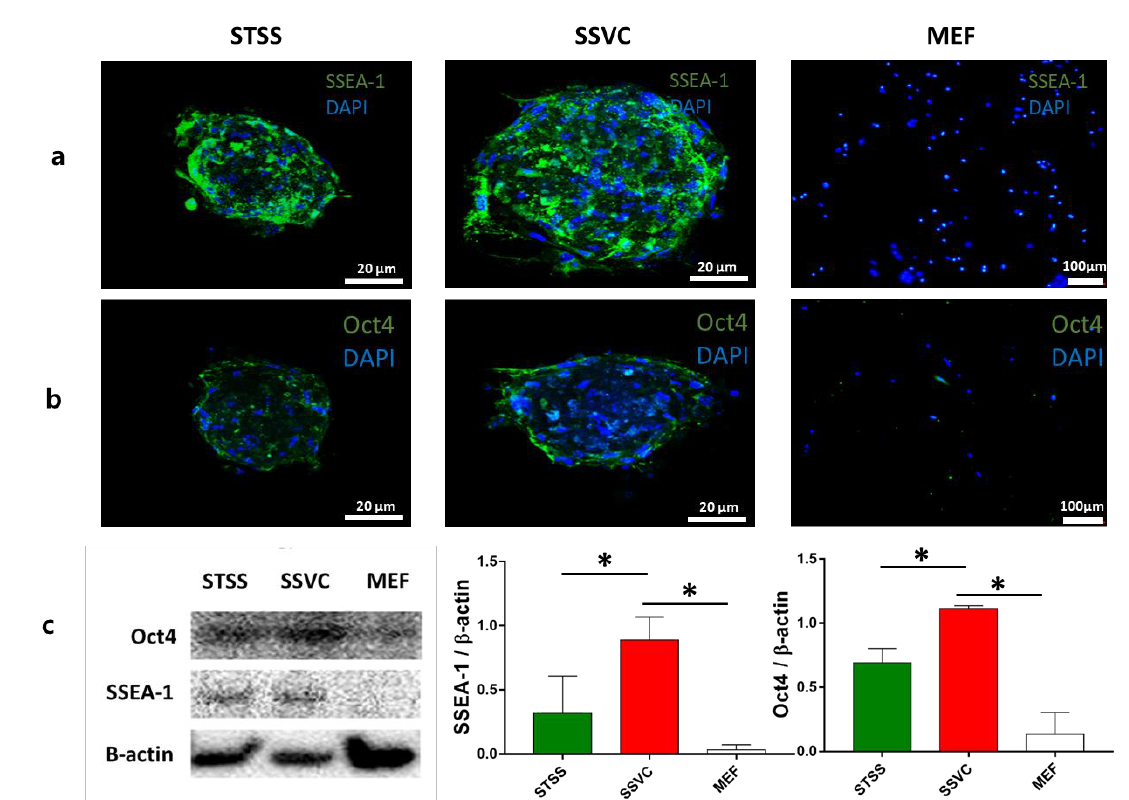
Figure 3. Comparison of pluripotency markers for STSS- and SSVC-generated spheroids. ( a ) Fluorescence images of SSEA-1-expressing spheroidal cells. ( b ) Fluorescence images of Oct4-expressing Scheme 20 µ m. ( c ) Western blot analysis determined that SSVC experimental group showed significantly higher expression of Oct4 and SSEA-1 pluripotency markers than the STSS and control MEF group (error bars represent standard deviation, * p < 0.05 was considered to be statistically significant, n = 3).